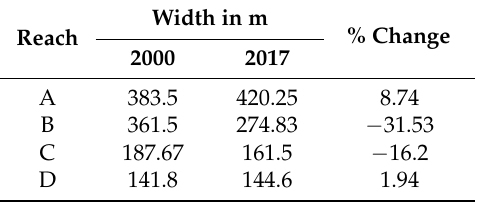
Table 1. Average temporal river width along each reach .